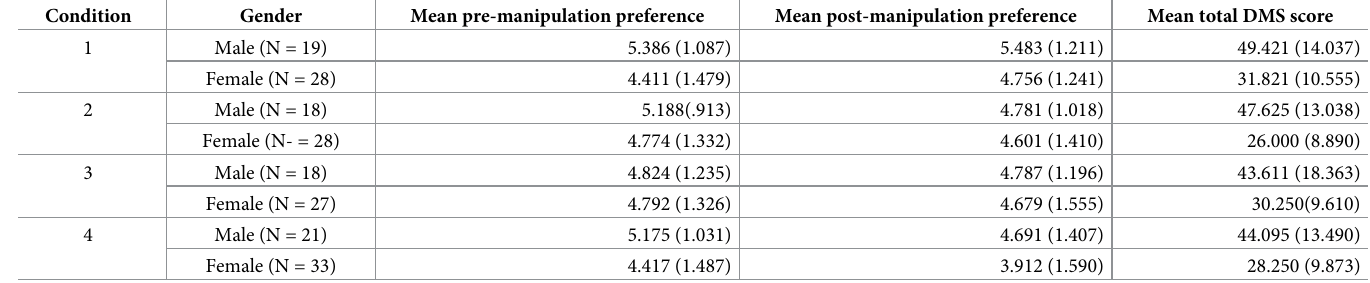
Table 1. Tabulated mean (standard deviation) pre- and post-manipulation preference for muscularity scores, and total drive for muscularity scale scores (DMS) for each gender across the four manipulation conditions.